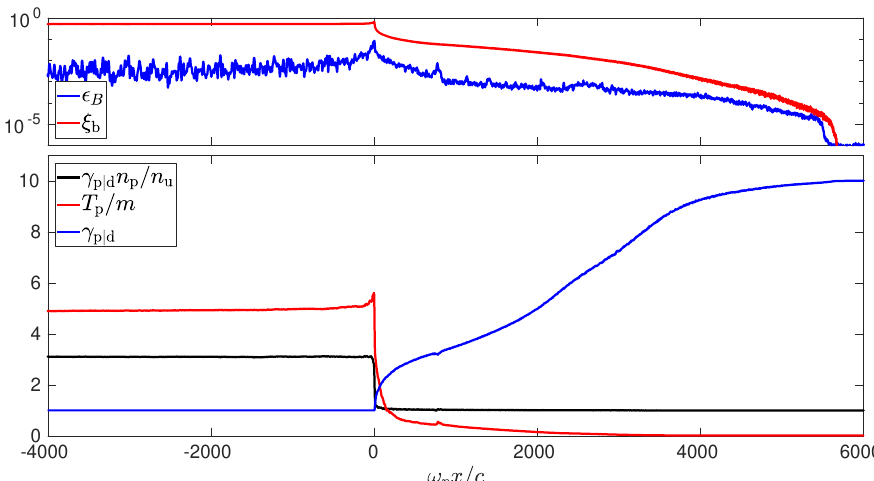
Figure 4. Transversely averaged profiles of the main hydrodynamical quantities in a 2D3V pair shock simulation with initial Lorentz factor γ ∞ | d = 10 and temperature T = 10 − 2 m e . Top panel: beam pressure (red), mean magnetization (blue). Bottom panel: total apparent electronic density in the downstream frame (black), Lorentz factor (blue) and proper temperature (red). Adapted from